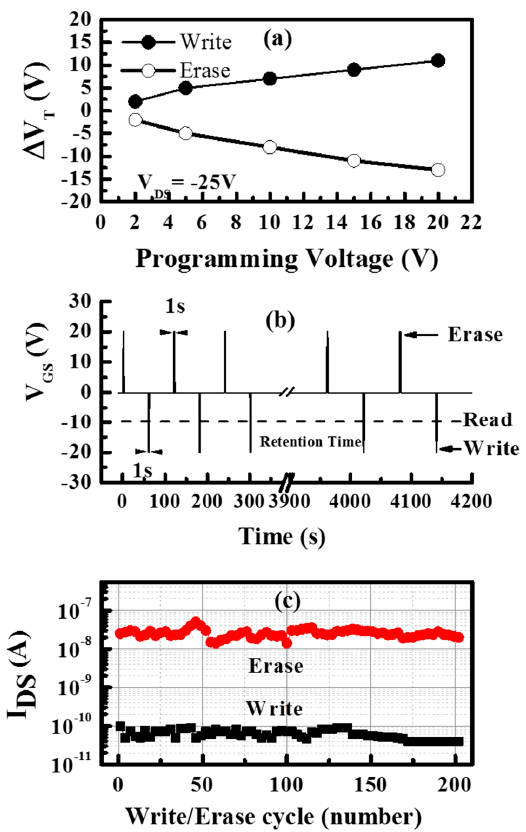
Figure 6. ( a ) Programming characteristics; ( b ) pulses sequence and ( c ) retention current for the SWCNT-based OTFMT.